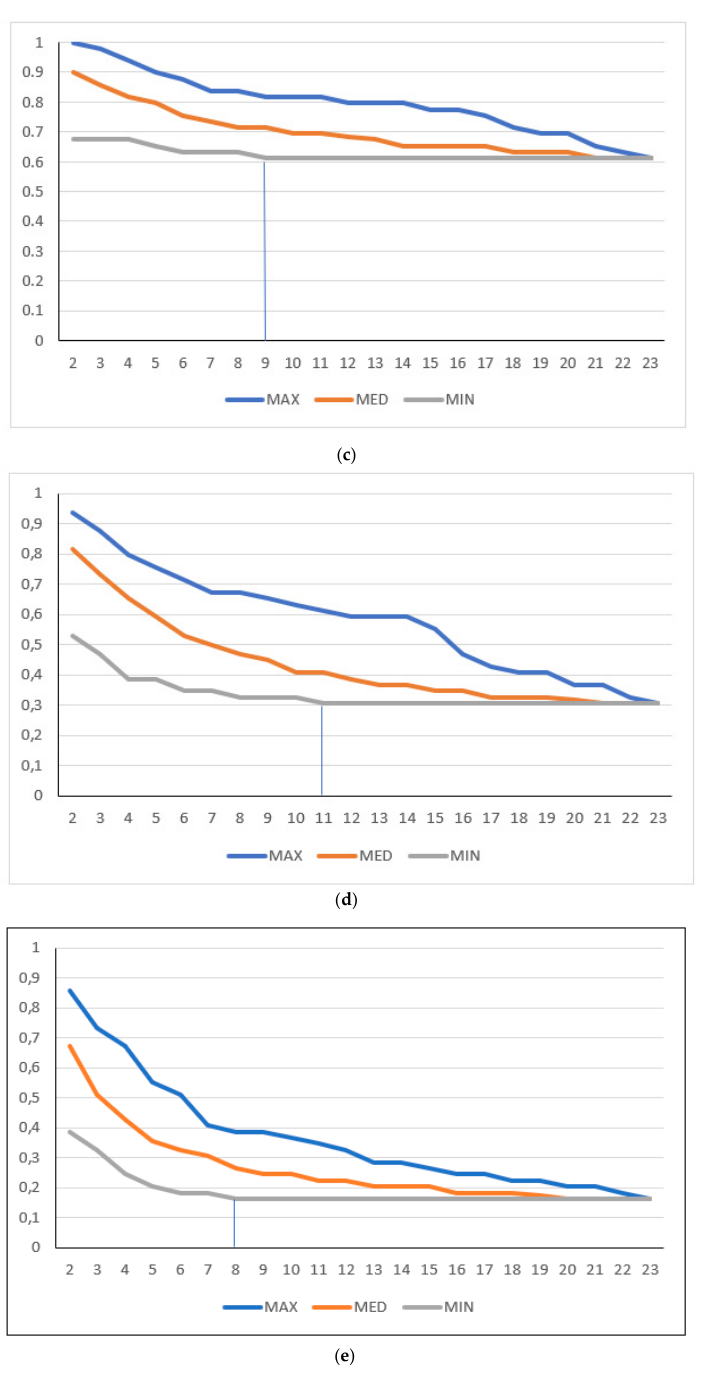
Figure 1. ONEST plots of different cut-off values for 23 pathologists. ( a ) Full and ( b ) simplified ONEST plots for the 49 cases assessed by 23 pathologists for a cut-off of <50% vs. ≥ 50% sTILs. ( c – e ) Simplified ONEST plots for further cut-off values studied: ( c ) <60% vs. ≥ 60%; ( d ) <30% vs. ≥ 30%; and ( e ) <20%, 21–50%, >50%. Readings from the plots are included in Table 1. OPA (n = 23) values are the OPA values at the right side of the plots and reflect the proportion of cases with full agreement. ONEST values correspond to the number of observers on the x-axis, where the minimum curve levels off, and no substantial decrease is noted with further increase in the number of observers (this is highlighted by vertical segments between the x -axis value and the minimum curve). The bandwidth of the ONEST plot is visualised on the left side of the plot as the difference between the maximum and the minimum curves with 2 observers; this is the largest difference in agreement between two observers.